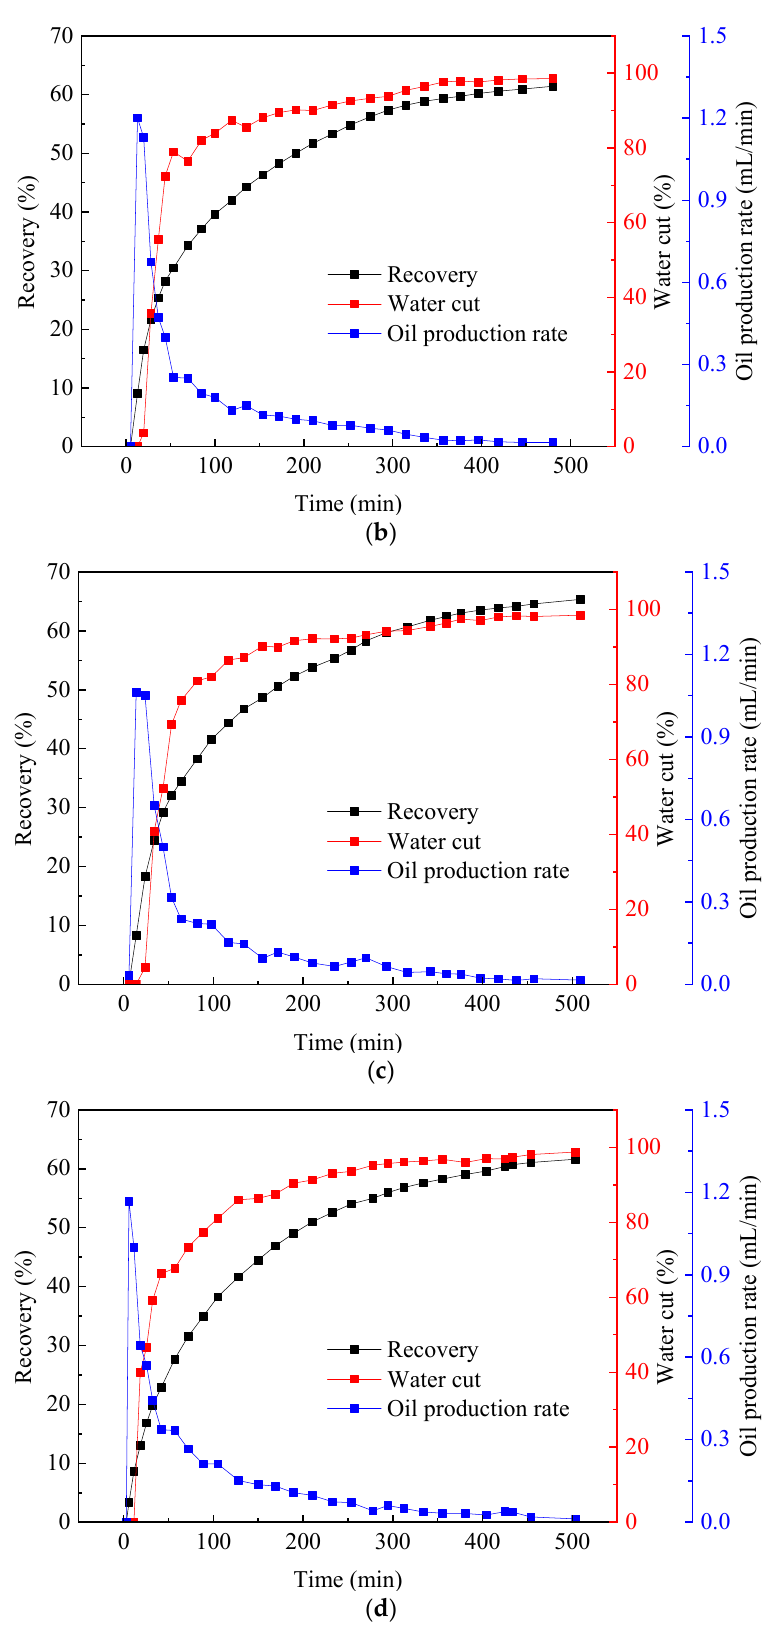
Figure 4. The liquid production characteristic curves under different flooding methods: ( a ) pure steam flooding, ( b ) N 2 + steam flooding, ( c ) CO 2 + steam flooding, and ( d ) flue gas + steam flooding.